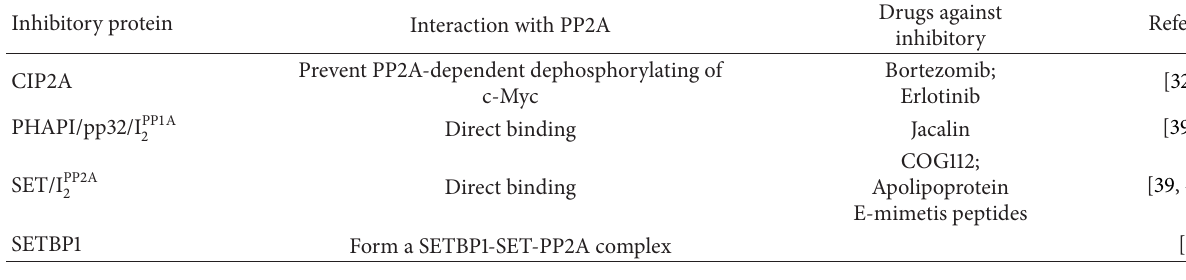
Table 3: Inhibitory protein of PP2A and possible related anticancer drugs.